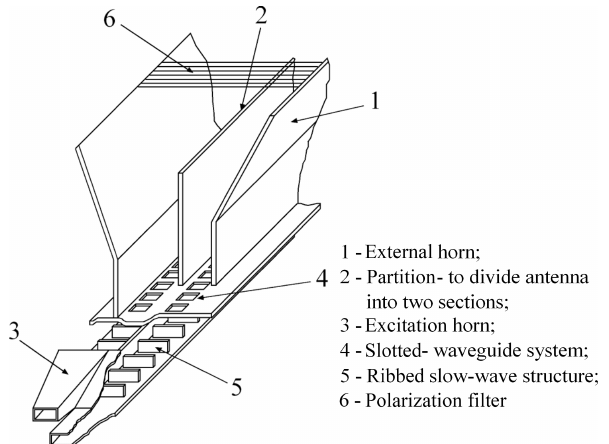
Figure 6. Structure of the IISR antenna.